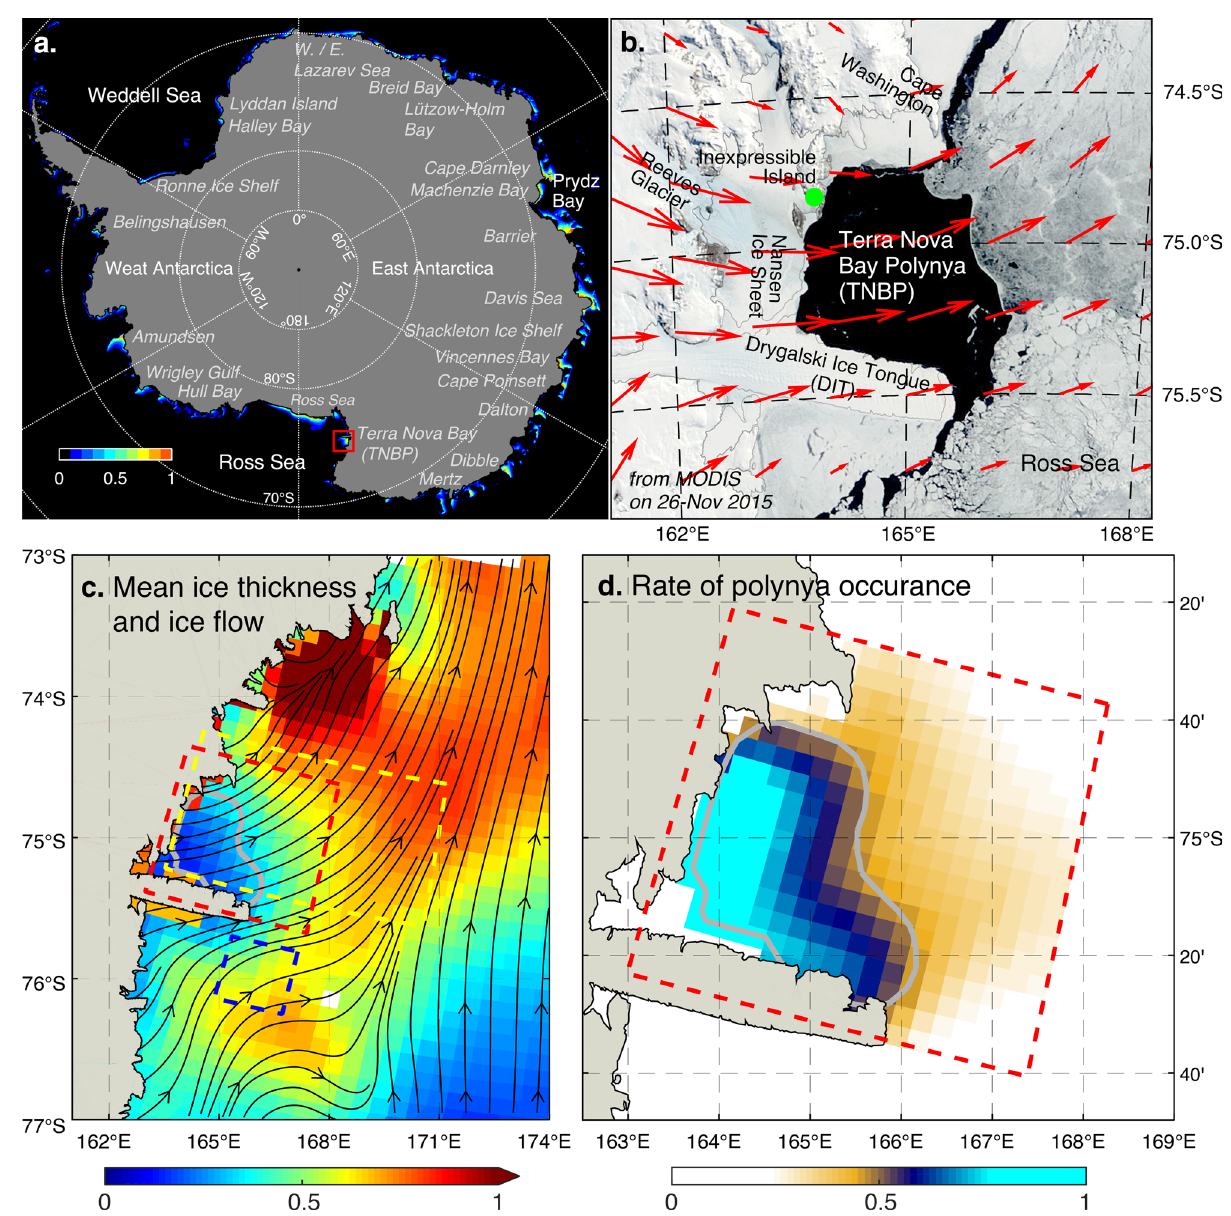
Fig. 1 Antarctic polynyas distribution, TNBP, and its surrounding geographic information. a is the occurrence ratio of Antarctica polynyas in the cold seasons in 2013~2020. Some well-known polynyas are marked. b The details in the red box shown in ( a ), the location of Manuela AWS position (green dot) and mean winds fi eld from ERA-5 data. The base map is from MODIS (https://worldview.earthdata.nasa.gov/) on 25 November, 2015. c Mean sea ice thickness (m) in the cold season (from 15 April to 15 October) from 2013 to 2020 respectively. The streamlines are ice drift derived from the empirical formula used in Thomas 46 . The grey line is the mean extent of the TNBP. The red box is the study area of the TNBP area, the blue box is where the TCI thickness is obtained, and the yellow box is the potentially affected region. The grey land mask comes from the GSHHG (a Global Self-consistent Hierarchical, High-resolution Geography database) coastline resources. d As in ( c ) but for the probability of polynya occurrence over